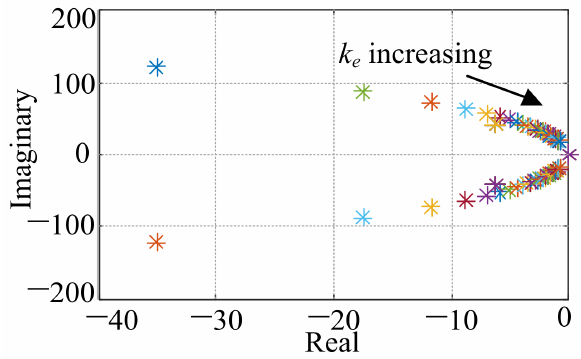
Figure 6. System dominant root locus at k e ∈ [1,